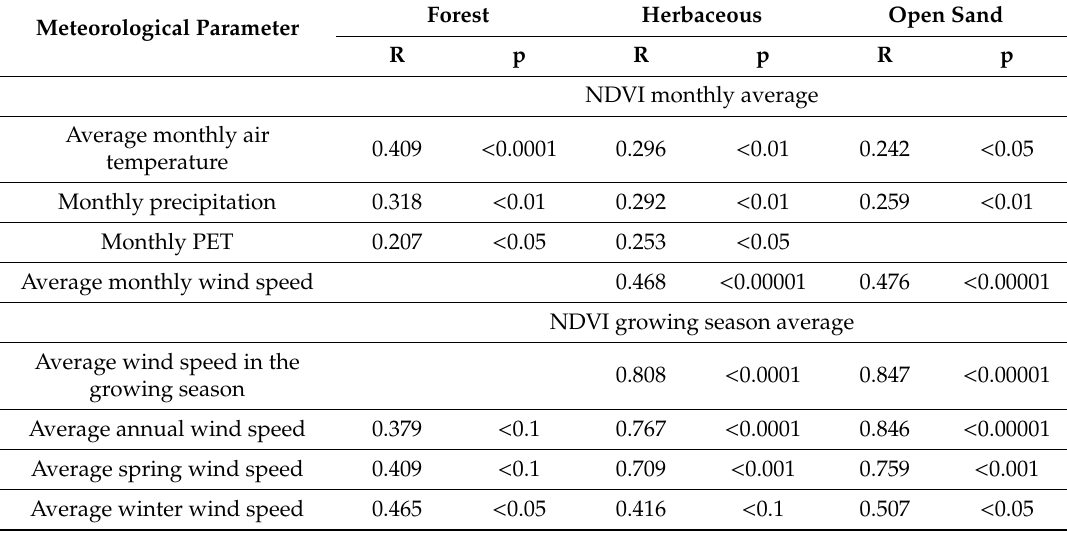
Table 5. Pearson correlation coe ffi cients (R) and statistical significance (p) comparing di ff erent ecosystems NDVI and meteorological parameters values during the growing season